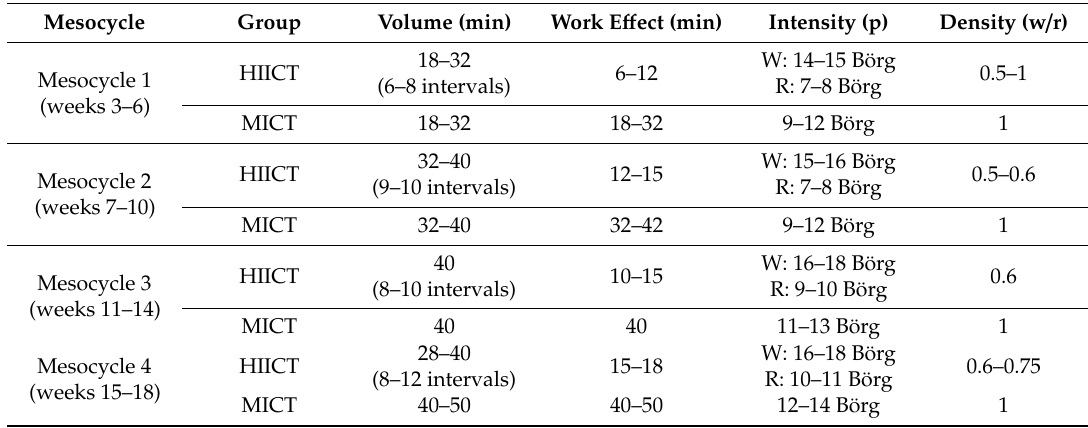
Table 1. Training progression for HIICT and MICT